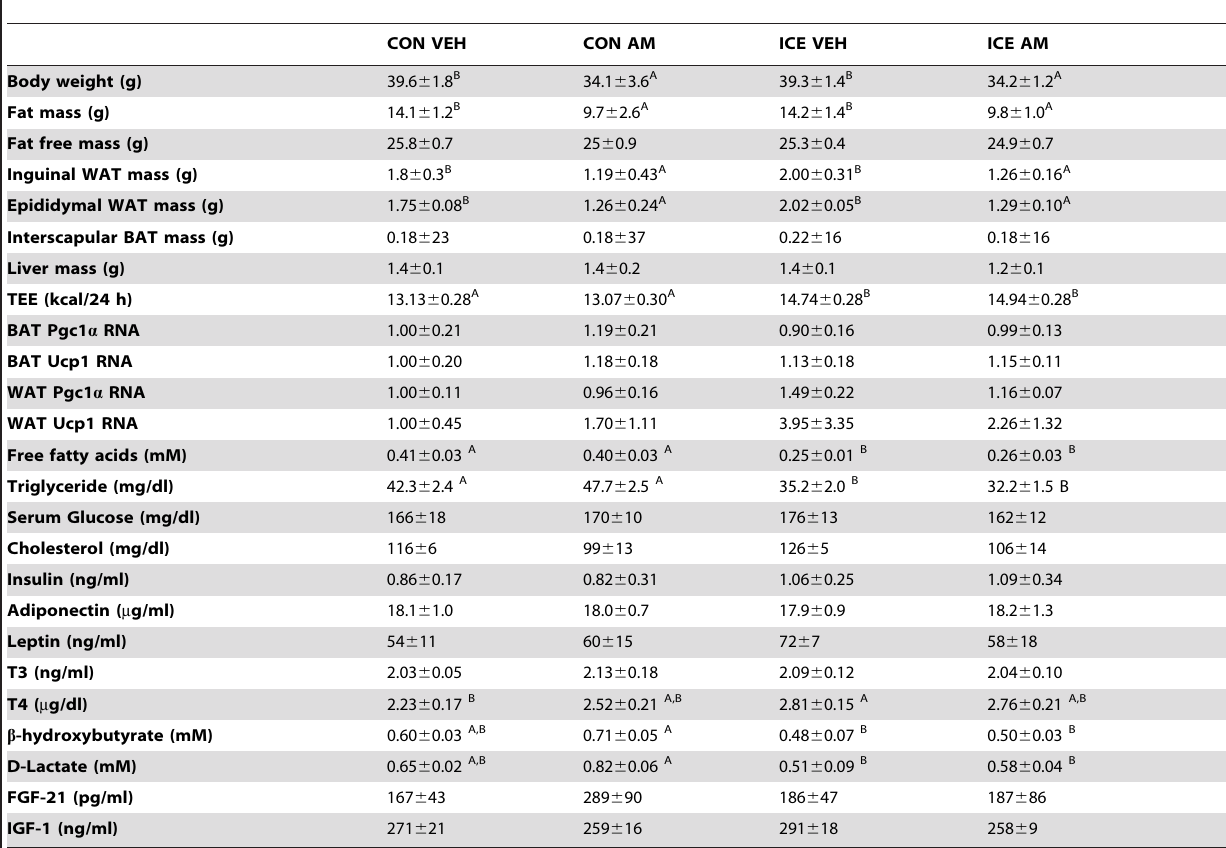
Table 4. ICE # 3, effect of daily AM251 and of 4 hours of cold exposure three times per